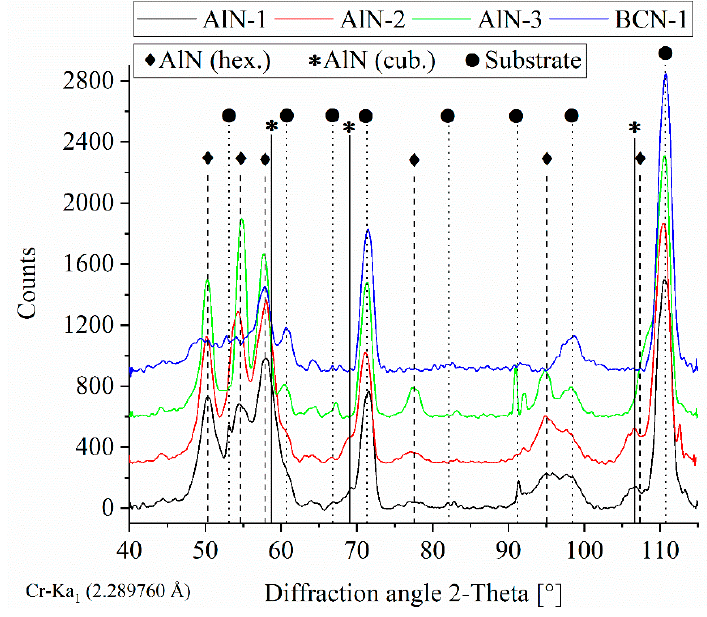
Figure 1. XRD patterns of the AlN-1, AlN-2, AlN-3, and BCN thin films deposited with various XRD patterns of the AlN-1, AlN-2, AlN-3, and BCN thin films deposited with parameters. various